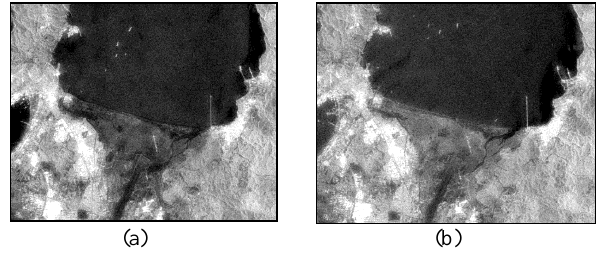
Figure 7. Result images after speckle noise removal: (a) Image before the disaster and (b) Image after the disaster